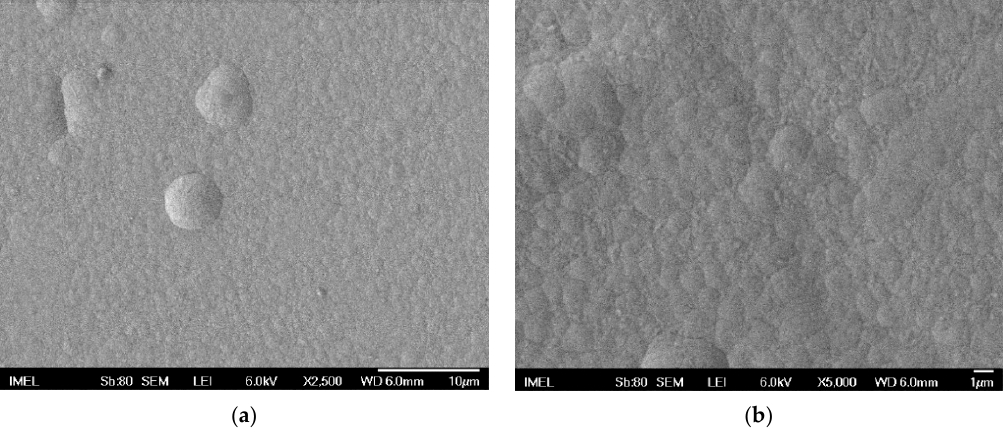
Figure 4. FE-SEM surface micrographs of pure Sn–Ni coating produced under direct current conditions at J = 1 A·dm − 2 ( a ) magnification ×2500, ( b ) magnification ×5000.